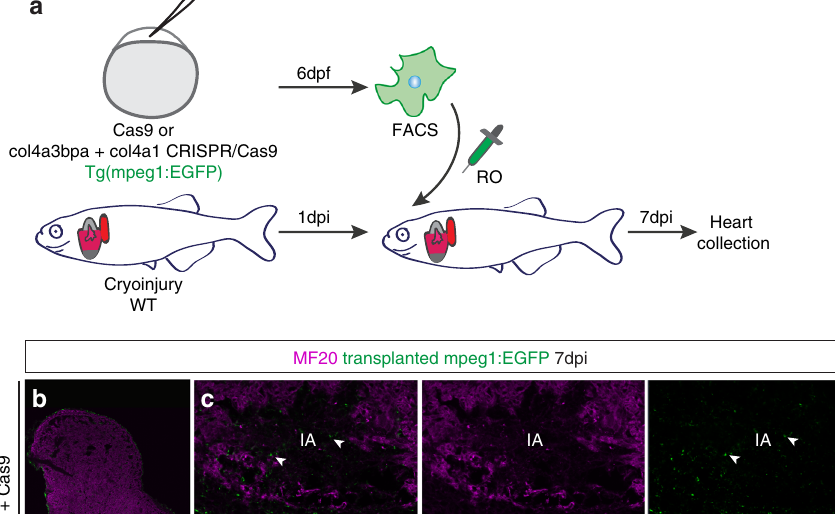
sequences, please check Supplementary Table 3. For HRMA primers, please check Supplementary Table 4. All components of the “ trio ” tagging were pre-assembled 24h in advance of injection and stored at − 20°C, as this was shown to increase ef fi ciency of integration of the donor vector. After the CRISPR/Cas9-mediated knock-in of the linearised donor fragment into the targeted intron of col4a1 in vivo, a fusion mRNA of Citrine fl anked by exons 23 and 24 of col4a1 was generated,